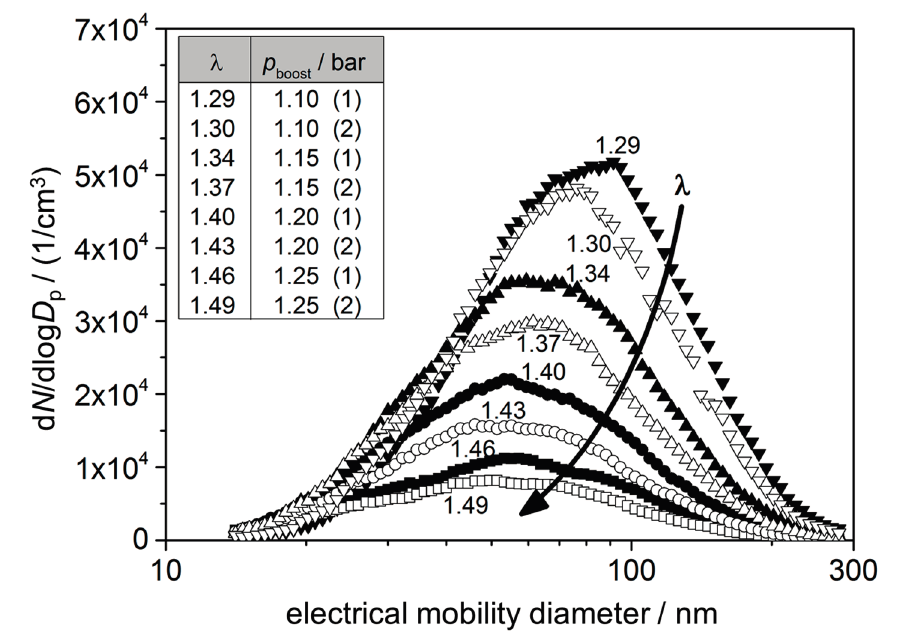
Figure 3. Result of soot analytics (SMPS) measurements for different operation points at 1000 rpm/25% accelerator position with B100 fuel. Only the boost pressure was changed ( p injection = const.), the other parameters are depended according to the engine characteristic map. Inset: correlation between boost pressure and resulting lambda values (the numbers in brackets indicate the first or second measurement